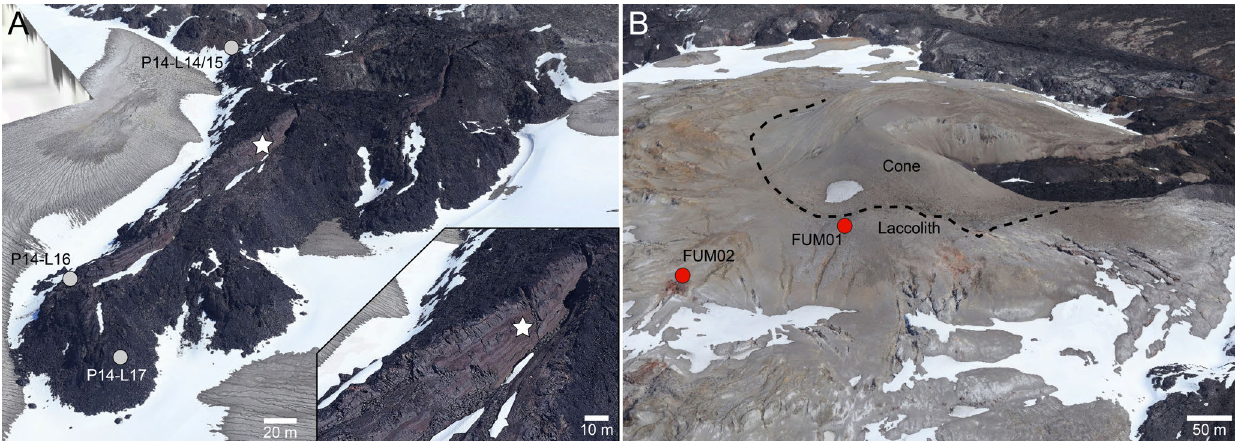
Figure 2: Key features of Cordón Caulle deposits. Images are from an aerial photogrammetry survey conducted in November 2017 [Schipper et al. (unpublished data)], corresponding to arrows marked in Figure 1. [A] Example breakout. Inset shows fracture that reveals internal textures of breakout material, indicating that the partially glassy upper surface is thin and that the majority of the flow is dense, holocrystalline material. [B] Overview of the 2011 vent, sitting atop the bulge created by syneruptive laccolith emplacement, and the locations of the